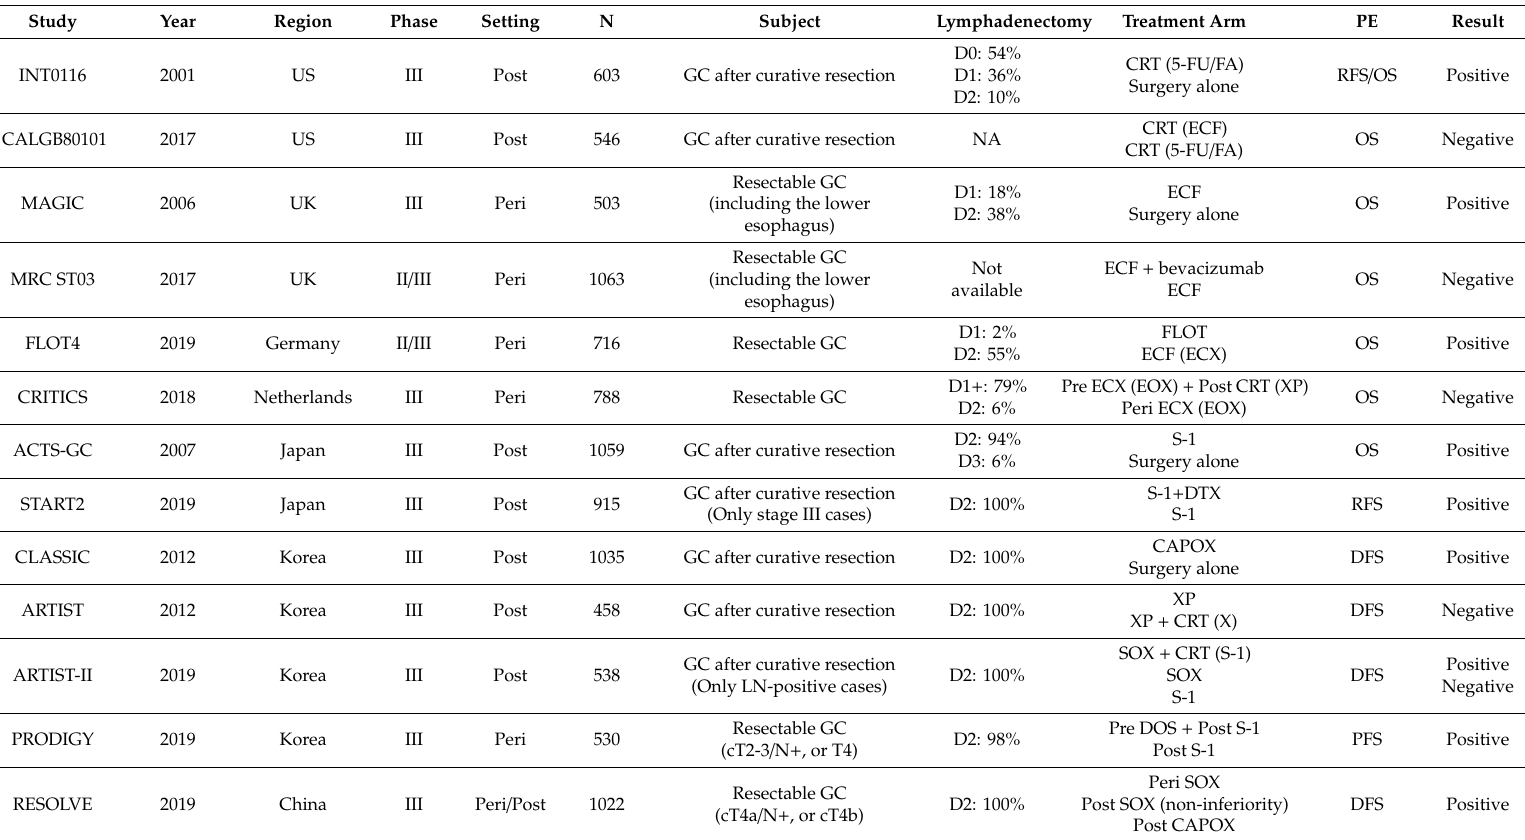
Table 1. Pivotal phase III (or II / III) trials of adjuvant therapy in gastric